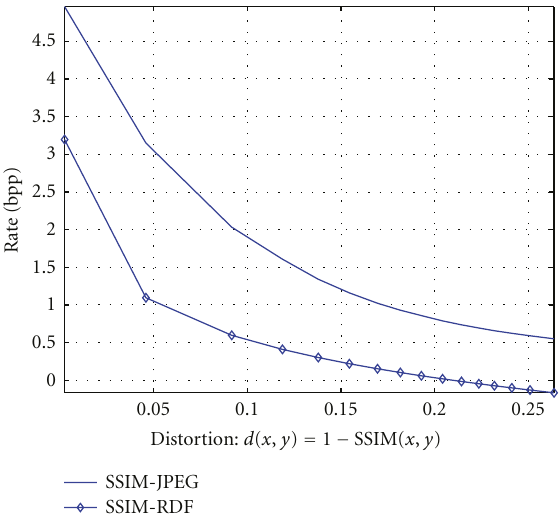
Figure 2: Operational RDF using the JPEG coder on the Lena image under the similarity measure d ( x , y ) = 1 − SSIM( x , y ) for block size 8 × 8. For comparison we have also shown the high-resolution SSIM-RDF (thin